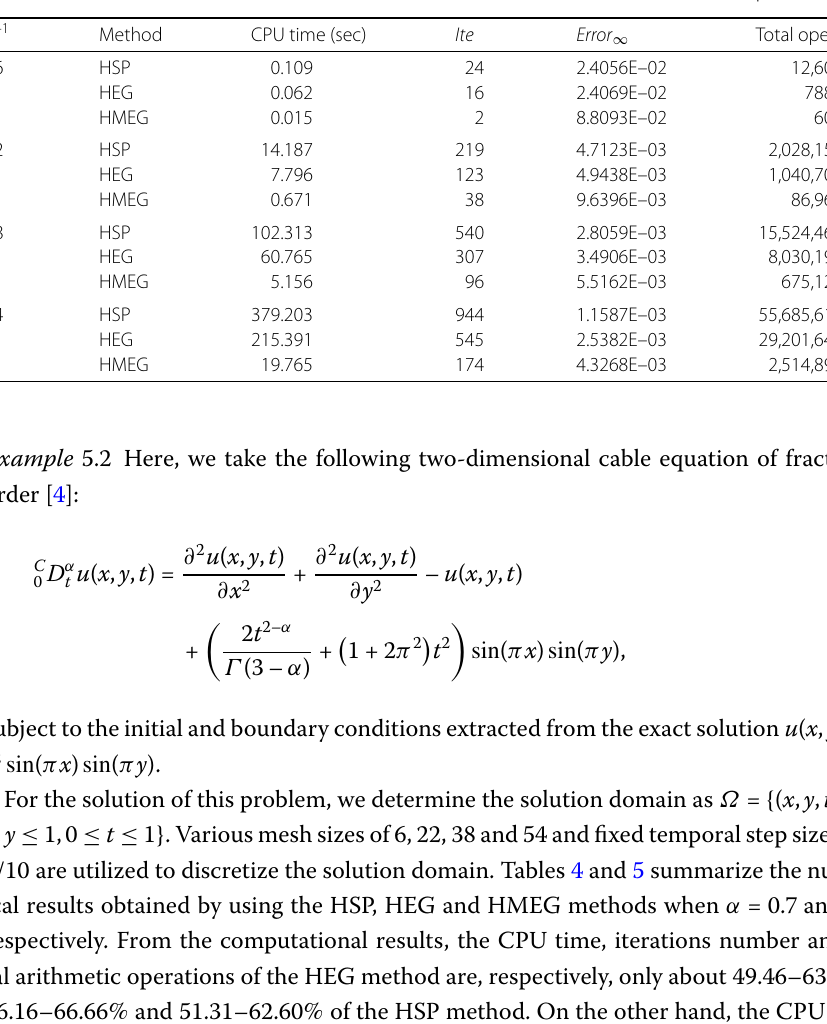
Table 4 The numerical results of the HSP, HEG and HMEG methods at α = 0.7 for Example